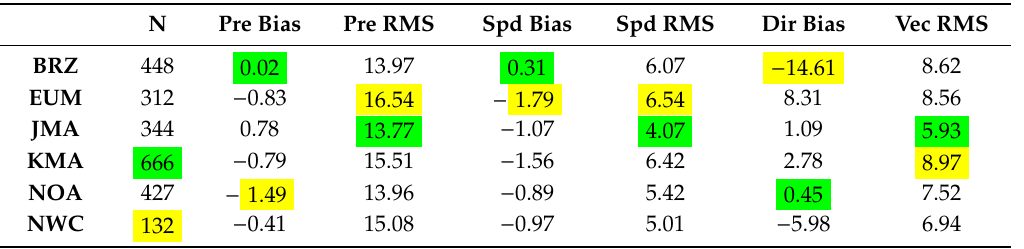
Table 4. The same as Table 3, but with CQI >= 80%.